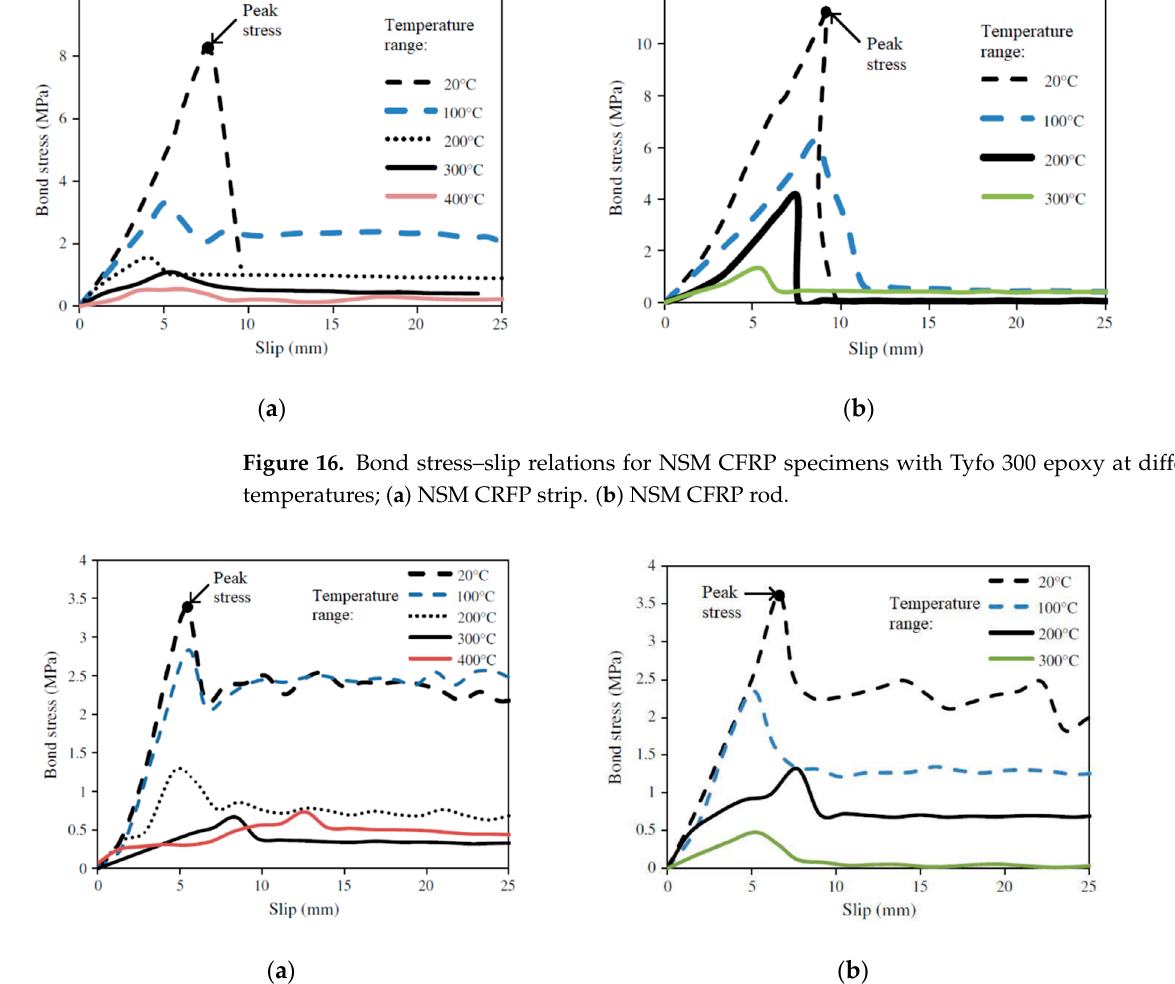
Figure 17. Bond stress–slip relations for NSM CFRP specimens with Tyfo S epoxy at different